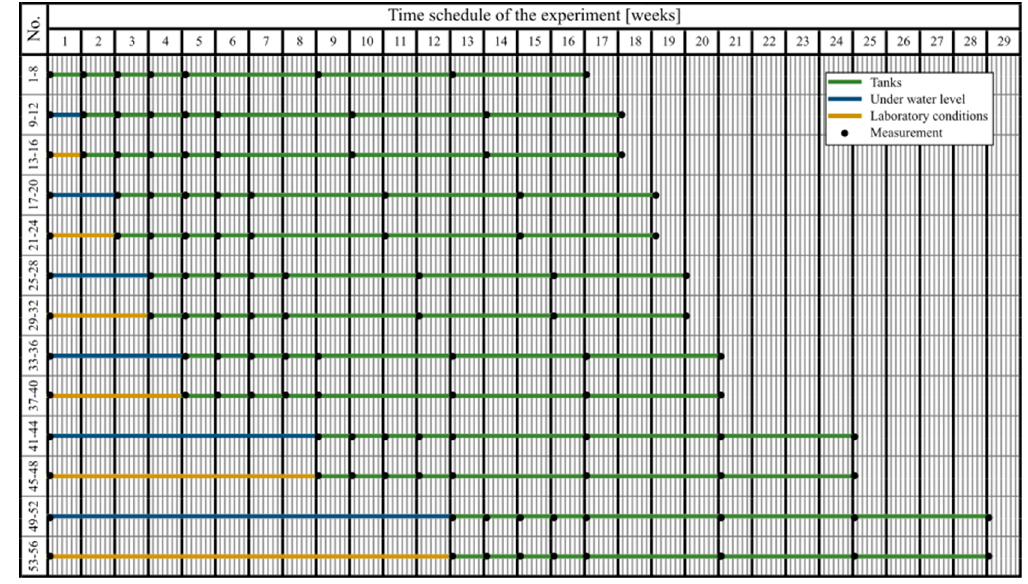
Figure 4. Time schedule of the second phase.